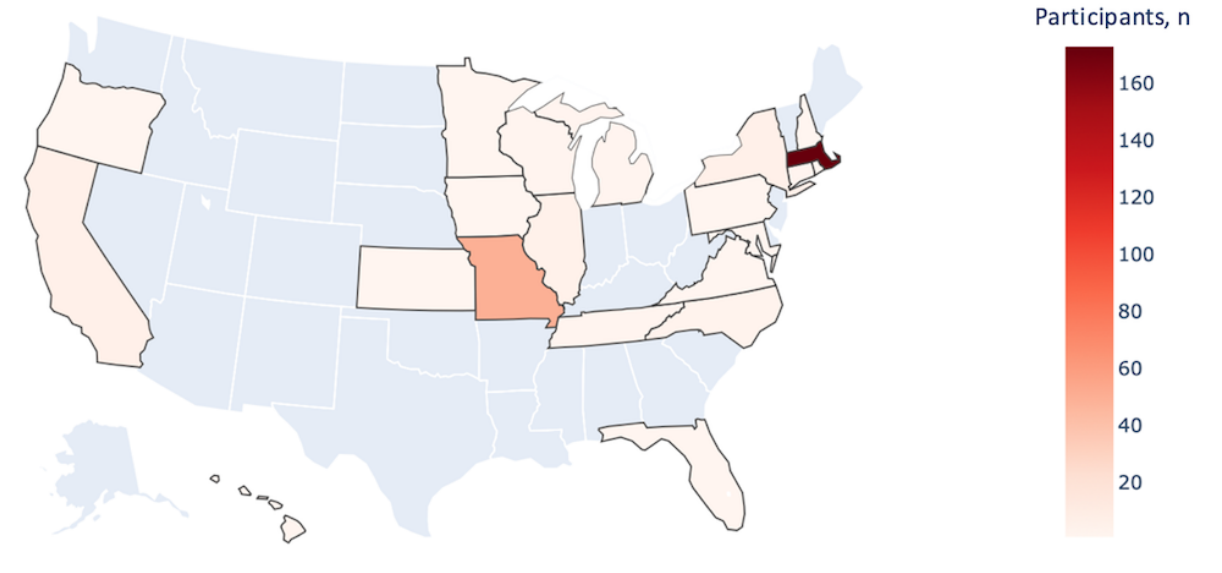
Figure 3. Ovulation and Menstruation Health Study participant population